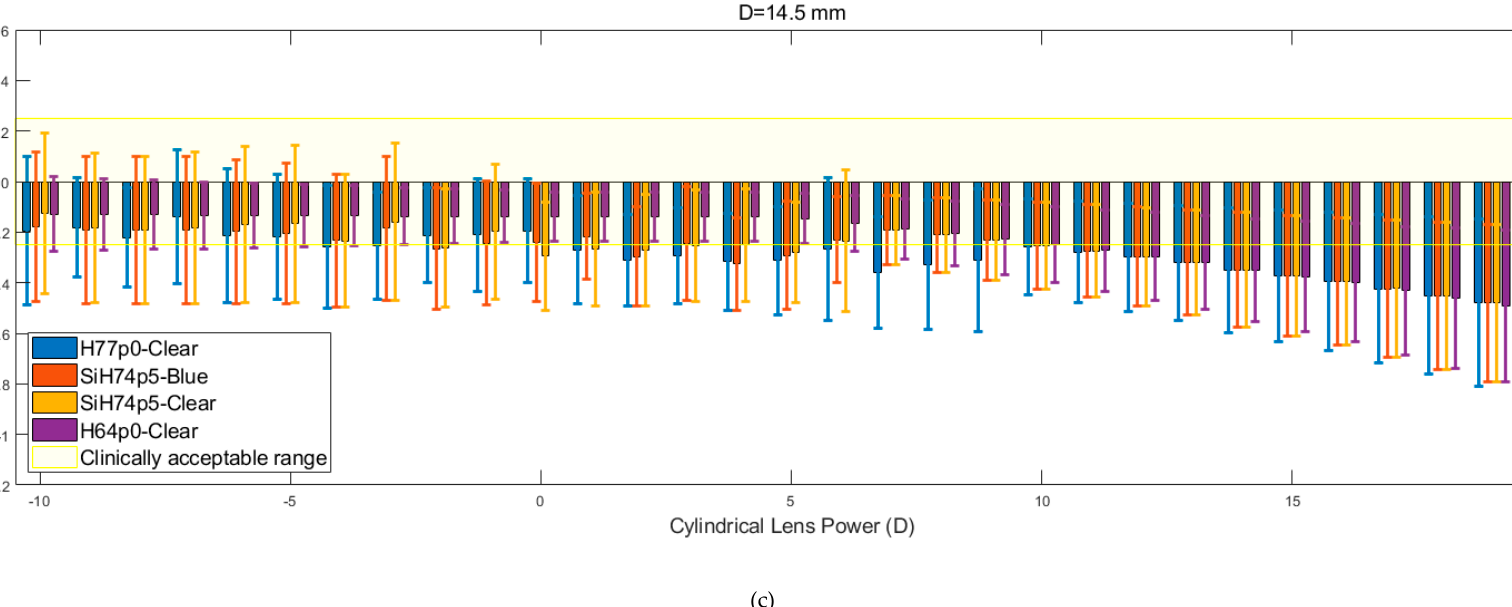
Figure 9. Effective power changes in cylindrical lenses for each of the four hydrogel materials. Results are presented for lens diameters D of 13.5 mm ( a ), 14.0 mm ( b ), and 14.5 mm ( c ).